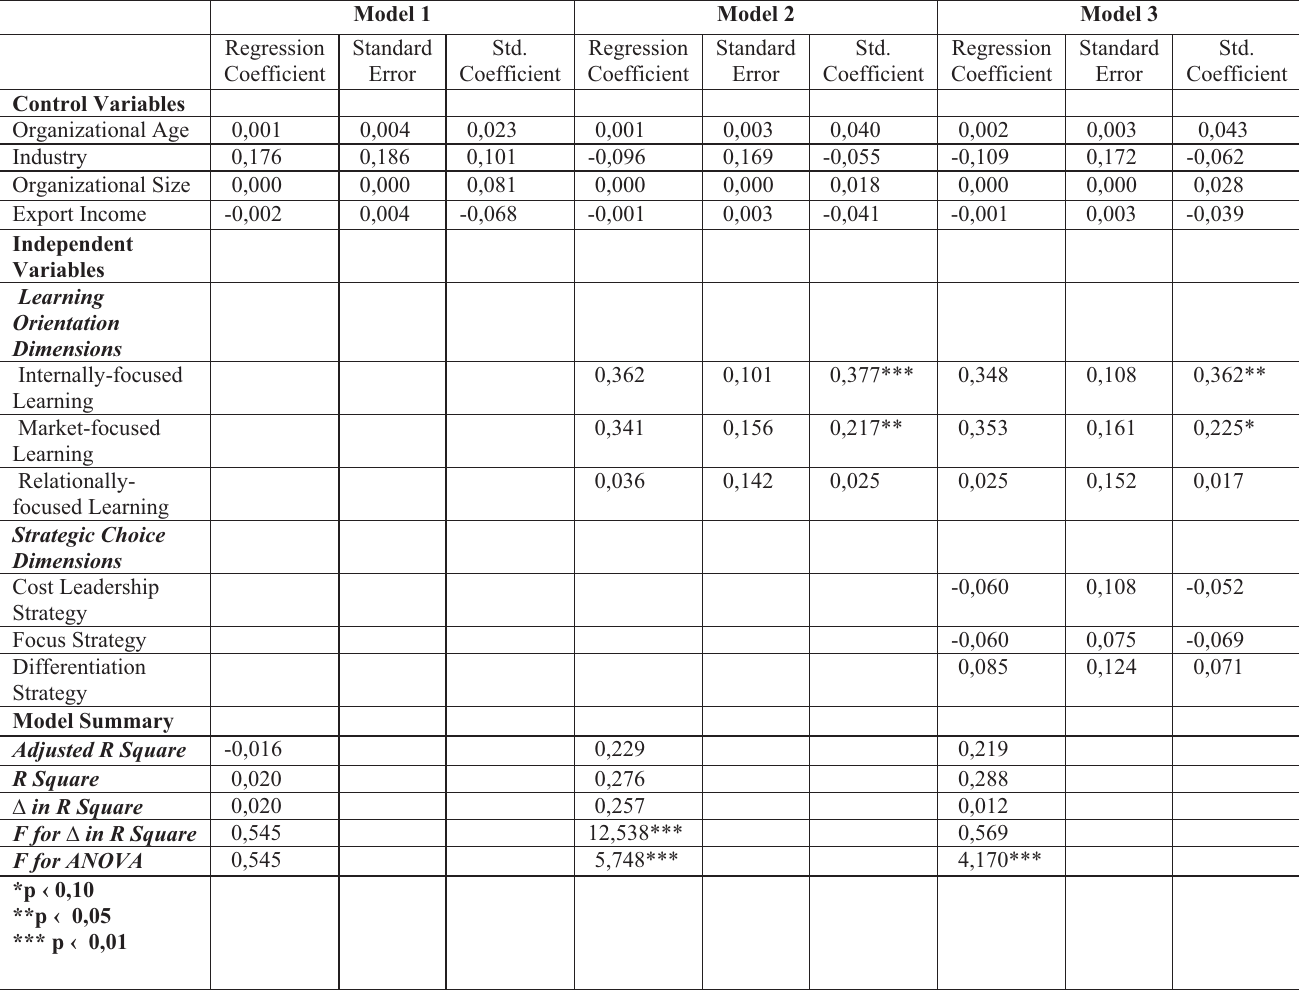
Table 4: Regression results for product